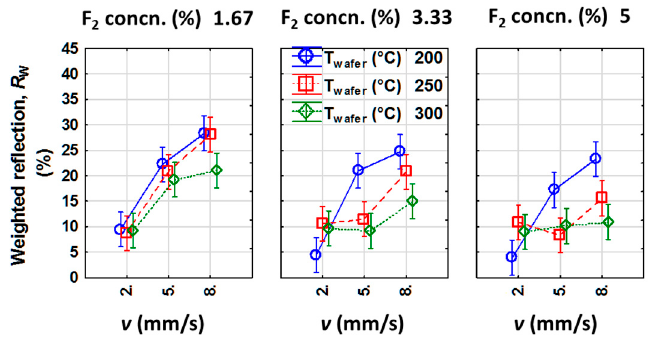
Figure 6. Plot of marginal means and confidence intervals showing interdependency of the most significant factors affecting R w . The lines are guides to the eye.